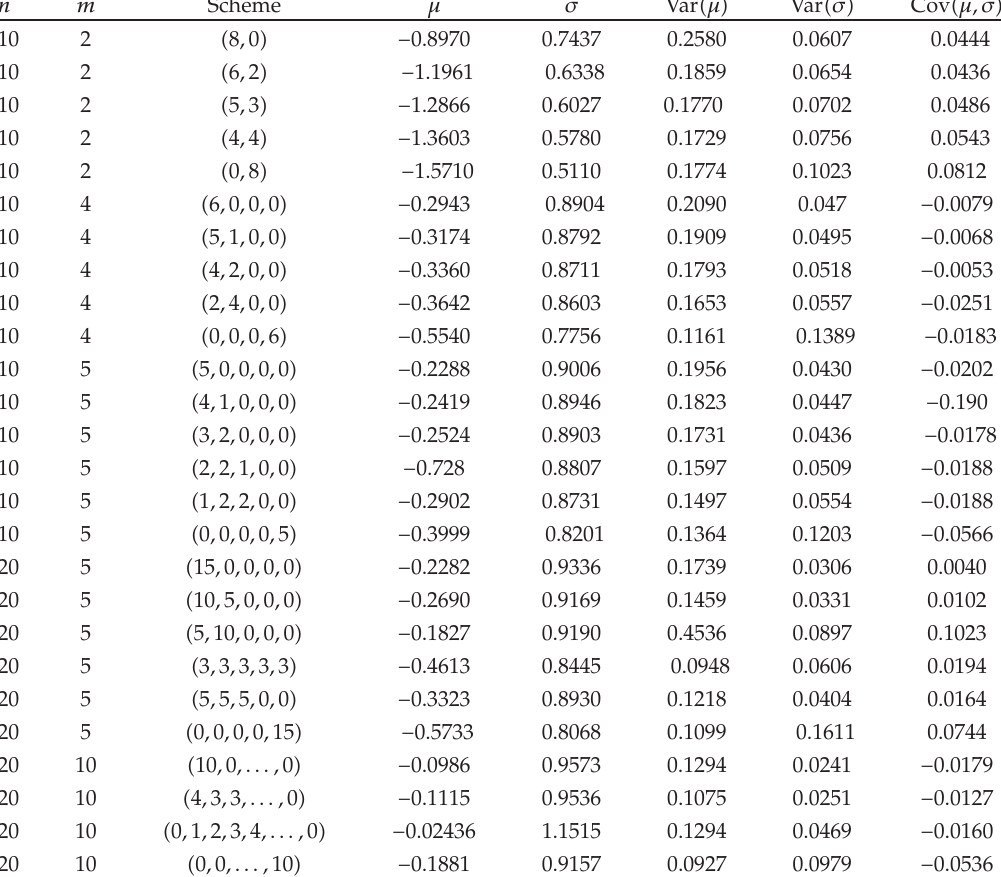
Table 8: Average, variances, and covariance of the MLEs when the shape parameter φ (cid:7)